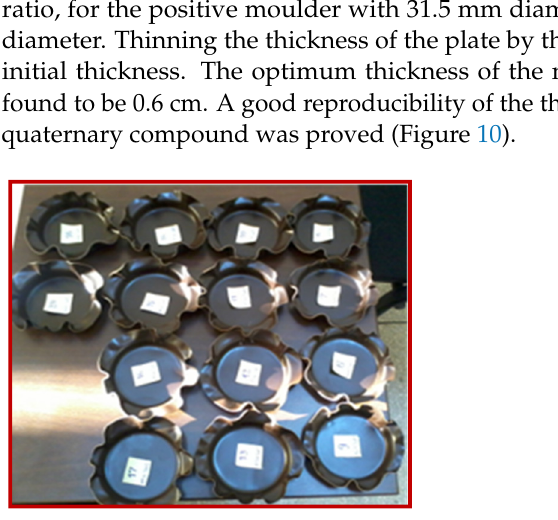
Figure 10. Items moulded from the selected starch-based material with target mineral and renewable fillers, thermoformed at 80 °C.